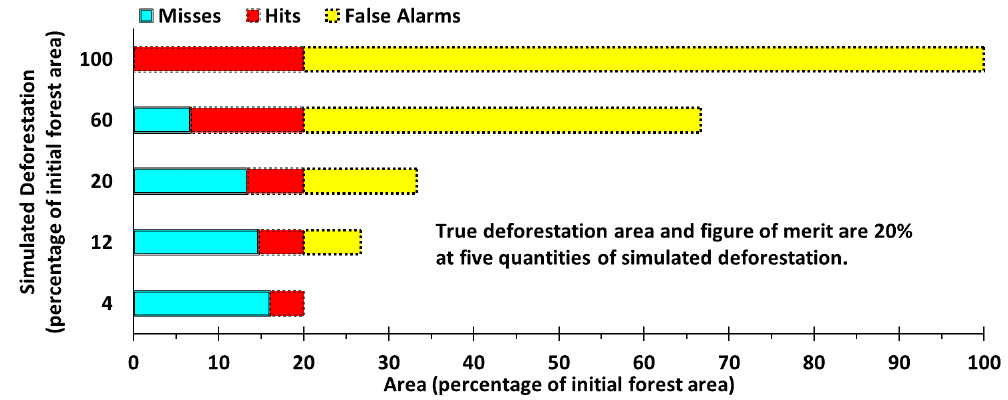
Figure 1. Venn diagrams to illustrate the Figure of Merit at five quantities of simulated deforestation.